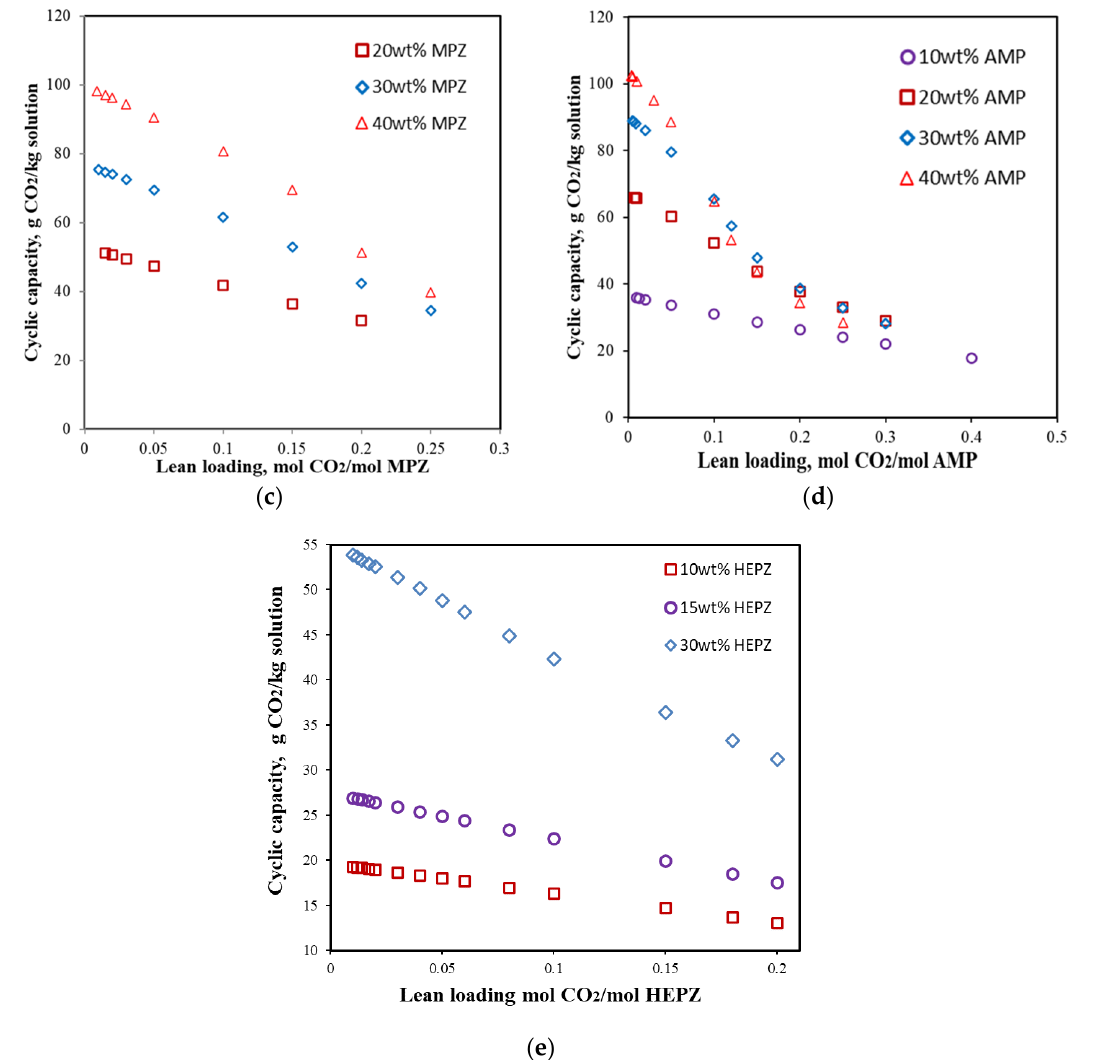
Figure 5. The influence relationship between the cyclic capacity and CO 2 -lean loading: ( a ) MEA, ( b ) DMEA, ( c ) 1-MPZ, ( d ) AMP and ( e ) HEPZ.